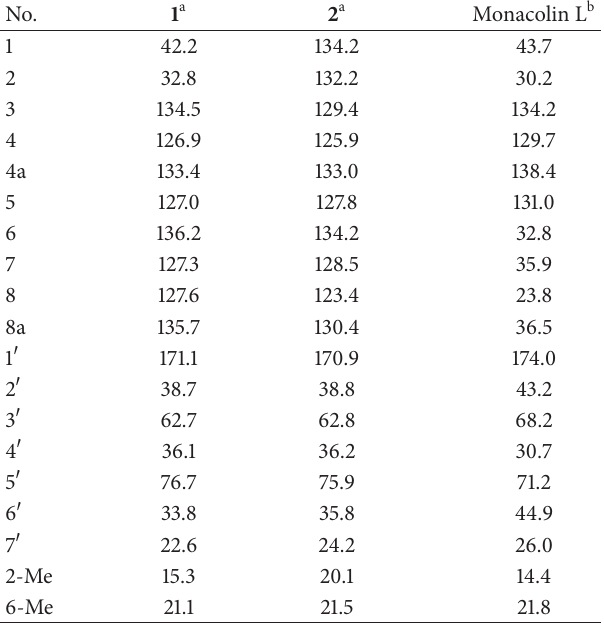
Table 2: 13 C NMR (150 MHz) data for 1 , 2, and monacolin